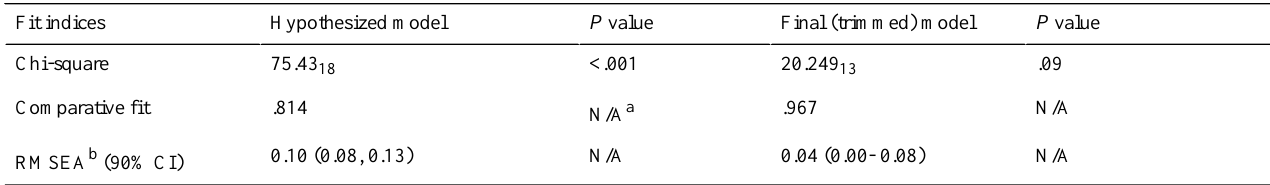
Table 2. Fit indices of the path model with smoking abstinence as outcome.